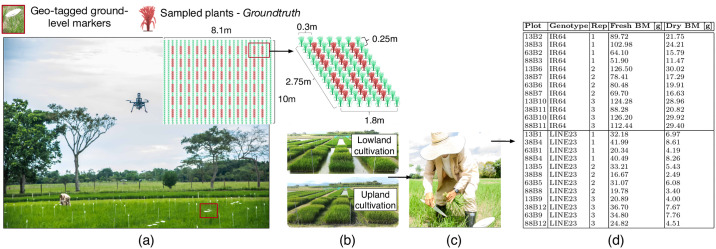
Crop setup: (a) Rice crops. (b) Each plot was designed with an area of 4.95m2. (c) Destructive biomass sampling. (d) An example of a Ground-Truth biomass (BM) dataset. The crop field was designed with three spatial repetitions (Rep) containing 2 contrasting rice genotypes.